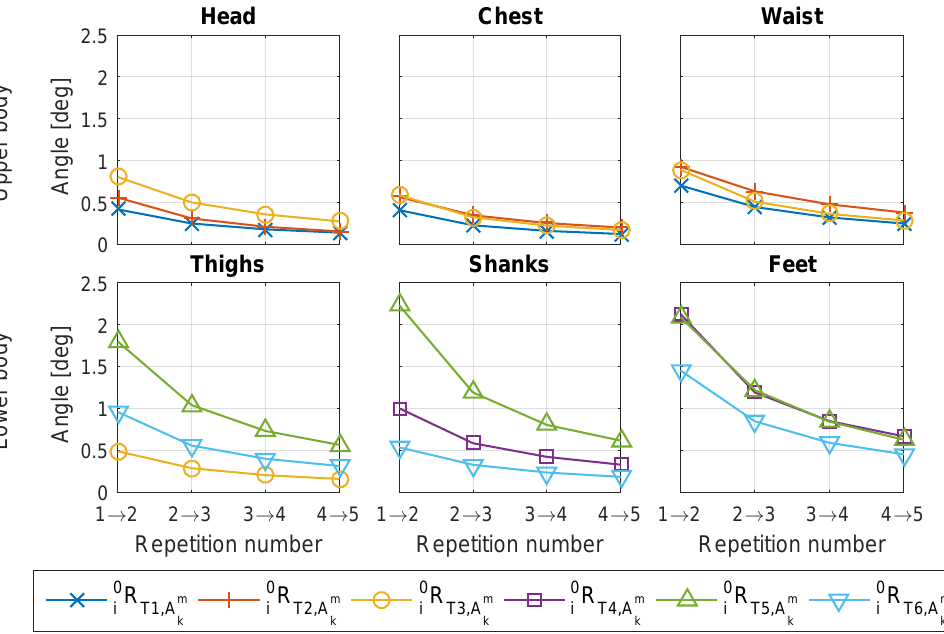
Figure 9. Averaged error angle when adding one more repetition (“increment”).